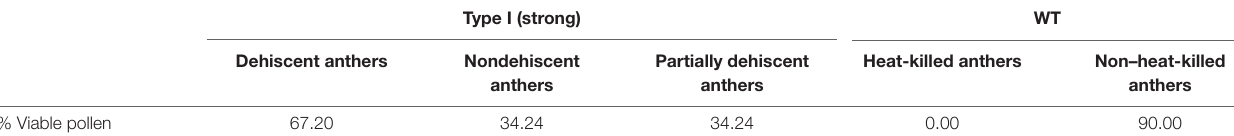
TABLE 2 | Percent pollen viability of type I (strong) transgenic tobacco flowers compared to WT.